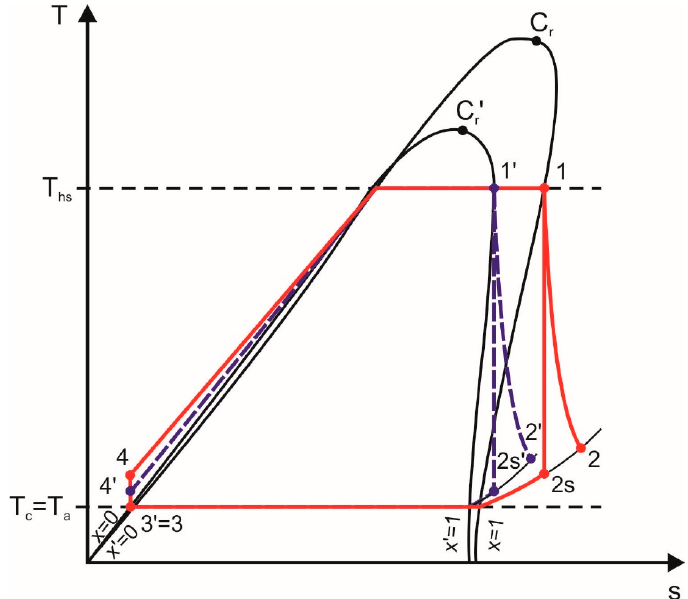
Figure 6. Comparison of two ideal ORC cycles adopting two different working fluids in the T–s plane. 4–1—isobaric heating and evaporation of the working fluid in the evaporator, 1–2s—isentropic expansion of the working fluid vapor in the expander, 1–2—polytrophic expansion of the working fluid vapor in the expander, 2–3—isobaric cooling and liquefaction of the working fluid in the